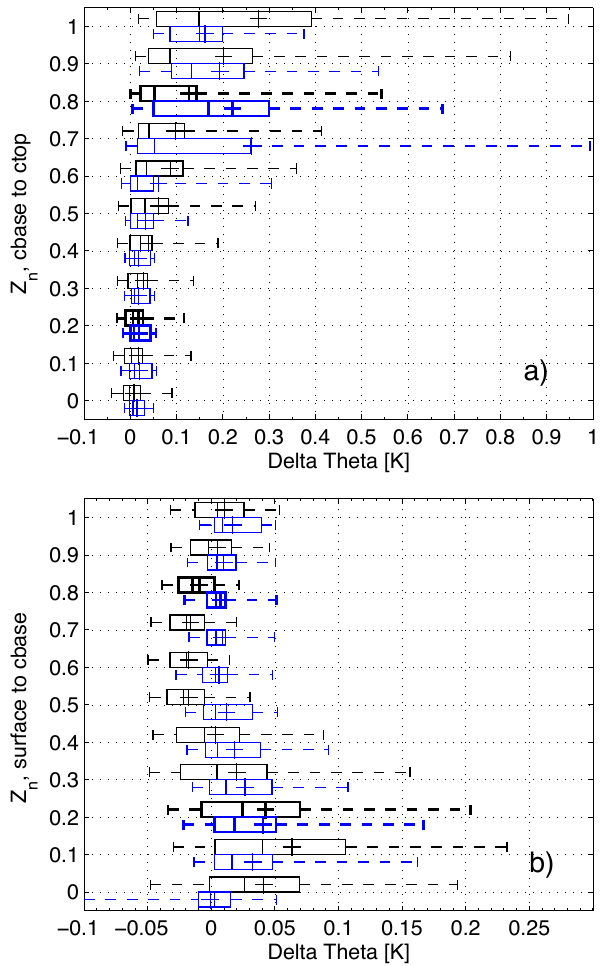
Fig. 5. Box-and-whisker distributions of δ2 derived from 60GHz scanning radiometer (black) and radiosounding (blue) profiles for (a) in-cloud δ2 [K] (normalized height profiles where cloud base is z n = 0 and cloud top is z n = 1) and (b) surface ( z n = 0) to cloud base ( z n = 1) δ2 . Data are shown for the full week 25–30 August. Median (vertical lines) and mean (crosses) δ2 within the interquar- tile boxes and 5–95th percentile (whiskers) distributions are shown. Bold distributions at z n = 0.2 and 0.8 in both panels represent statis- tically significantly different medians at the 99% level between the two heights using the two-sided Wilcoxon rank-sum significance test; these are shown to indicate significant differences in the me- dian δ2 profile shapes across the normalized